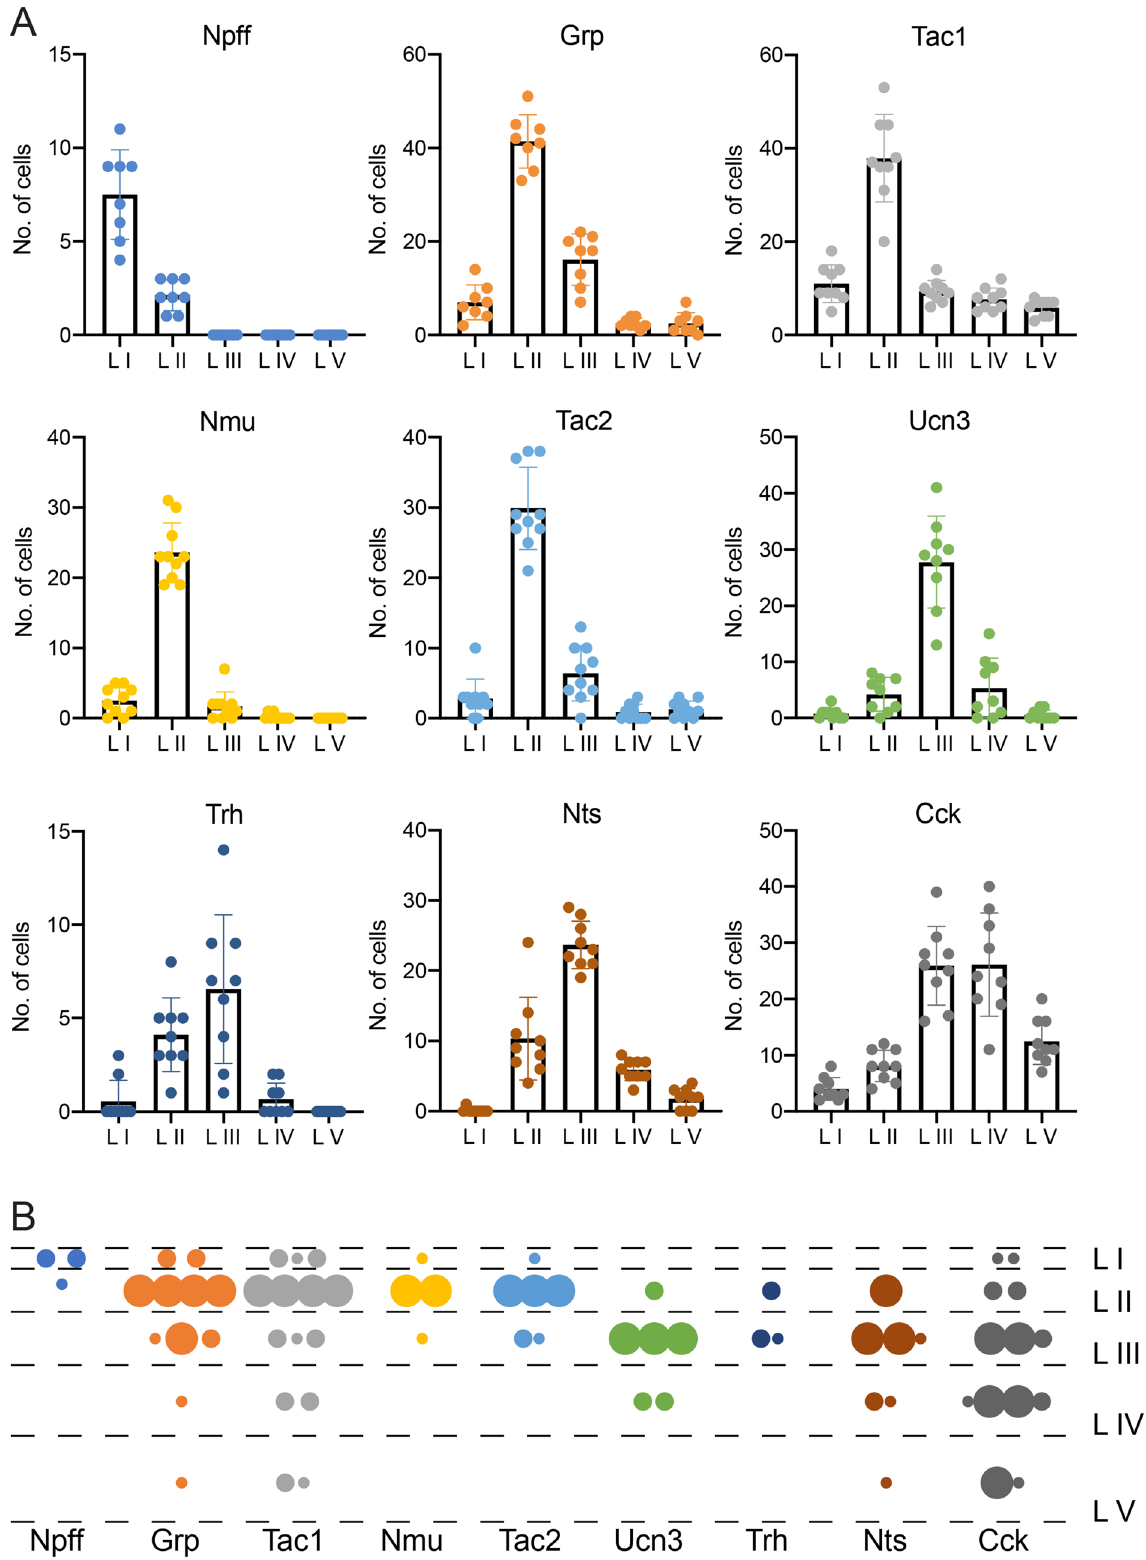
Figure 7. Laminar distribution of neuropeptides. ( A ) Number of cells per hemisection that express the depicted neuropeptide within the respective lamina of the spinal dorsal horn. Individual dots represent the number in a single hemisection (n = 8–10 hemisections from n = 3 mice). ( B ) Distribution of cells expressing the neuropeptide genes Npff , Grp , Tac1 , Nmu , Tac2 , Ucn3 , Trh , Nts and Cck among the laminae of the dorsal spinal cord. Small dots = 2 cells, medium sized dots = 4 cells, large dots = 10